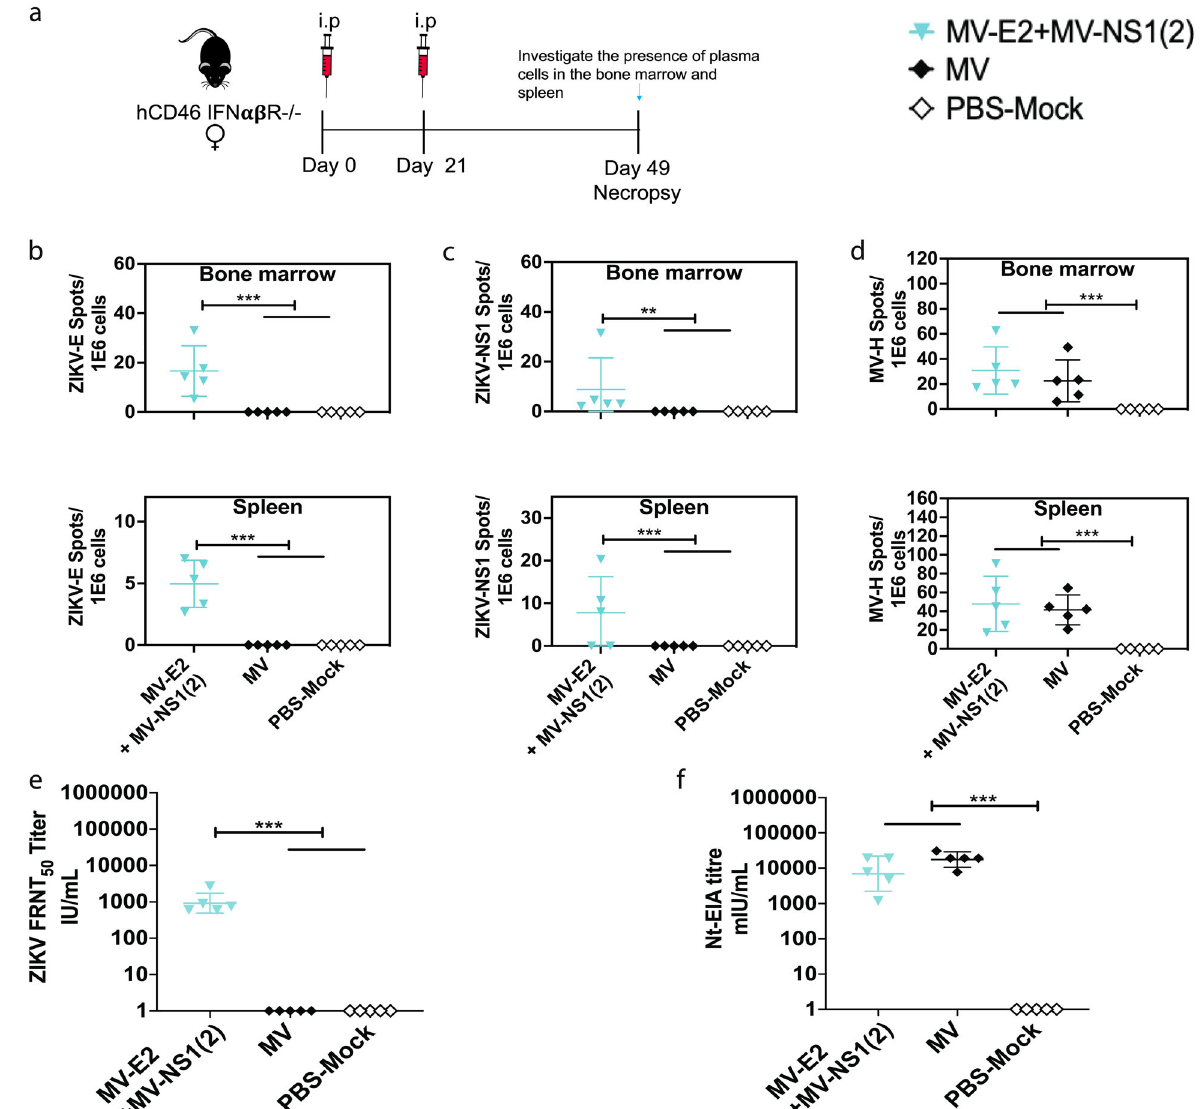
Fig. 5 Plasma cell responses induced by the MV-ZIKV vaccines. a Timeline of vaccination, bone-marrow and spleen harvesting. ZIKV-E speci fi c ( b ), ZIKV-NS1 speci fi c ( c ), and MV-H speci fi c ( d ) Plasma cells in the bone marrow and spleen. The mean of triplicates is depicted for each animal. Mean ± SD is depicted per group. e ZIKV Neutralization with PRVABC59 Asian strain. FRNT was performed on necropsy sera from vaccinated animals and controls. The mean 50% neutralizing titer of triplicate values is depicted per animal as IU/mL as ZIKV standards (Bei) were used. The Mean ± SD is depicted per group. f MV Neutralization with low-passage MV Edmonston strain. Nt-EIA assay was performed on necropsy sera from vaccinated animals and controls. The mean of 50% neutralizing titer (Nt-EIA titers) of triplicates is plotted per animal on the graph in terms of mIU/mL as bei standards were used. The Mean ± SD is depicted per group. Statistics for Fig. 5b – f were done using the one-way ANOVA with post hoc Tukey HSD test and performed on log-transformed data for each time point. P value of 0.1234(ns),